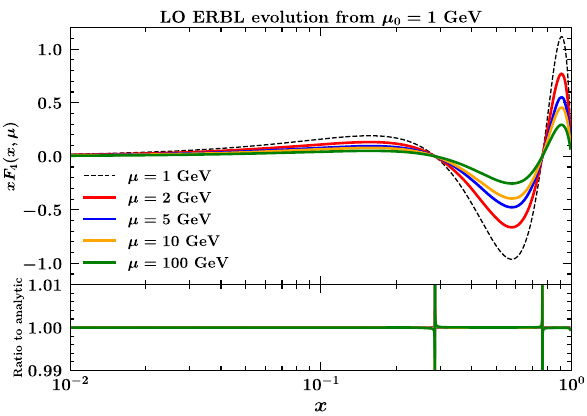
the MMHT2014lo68cl PDF set. To tame the fast rise of gluons at low- x , we weight the distribution with an additional power of x . The lower inset displays the ratio to the DGLAP evolution as delivered by the LHAPDF grid